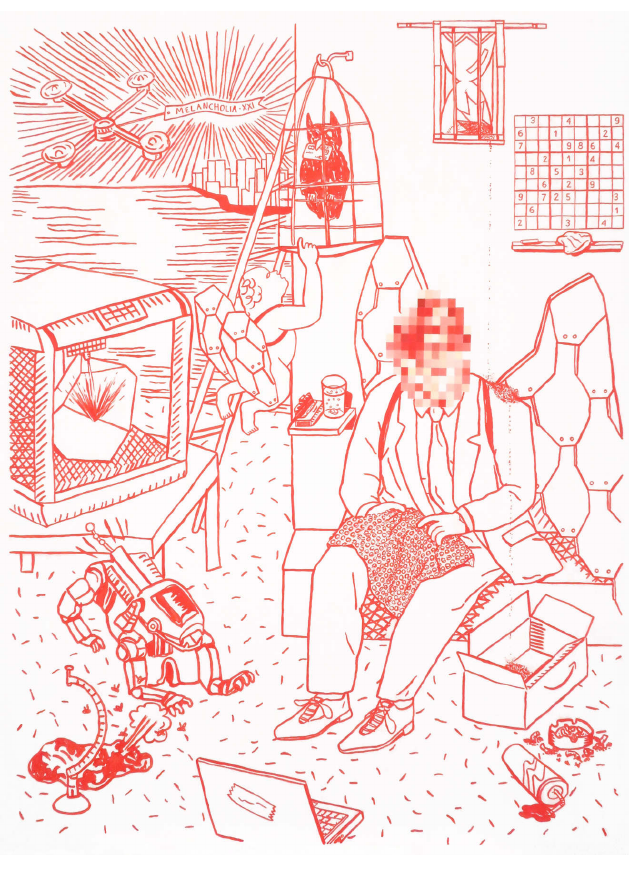
Fig.1 Bianca Argimón, Melancholia XXI , 2019, oil on linen, 125 x 95 cm. Courtesy